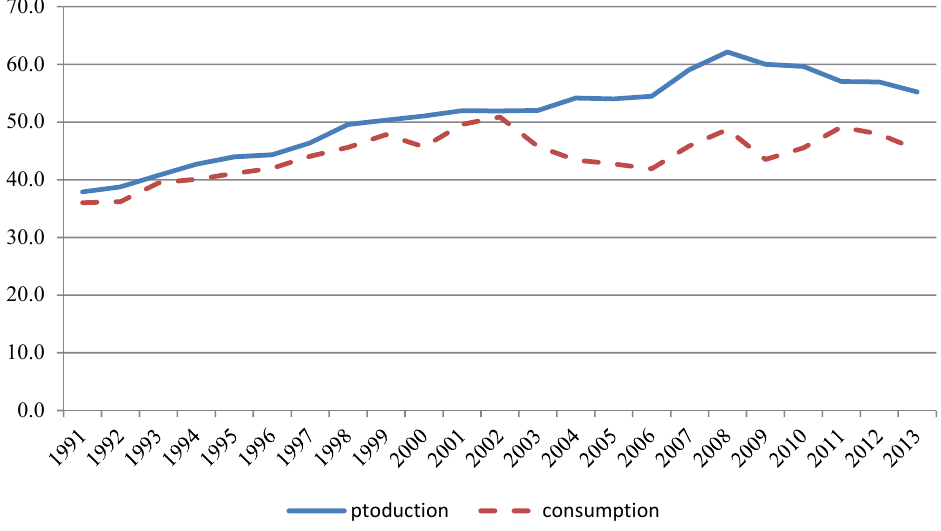
Fig. 3. Production and consumption of natural gas in Uzbekistan (billion cubic meters) Source: British Petroleum,